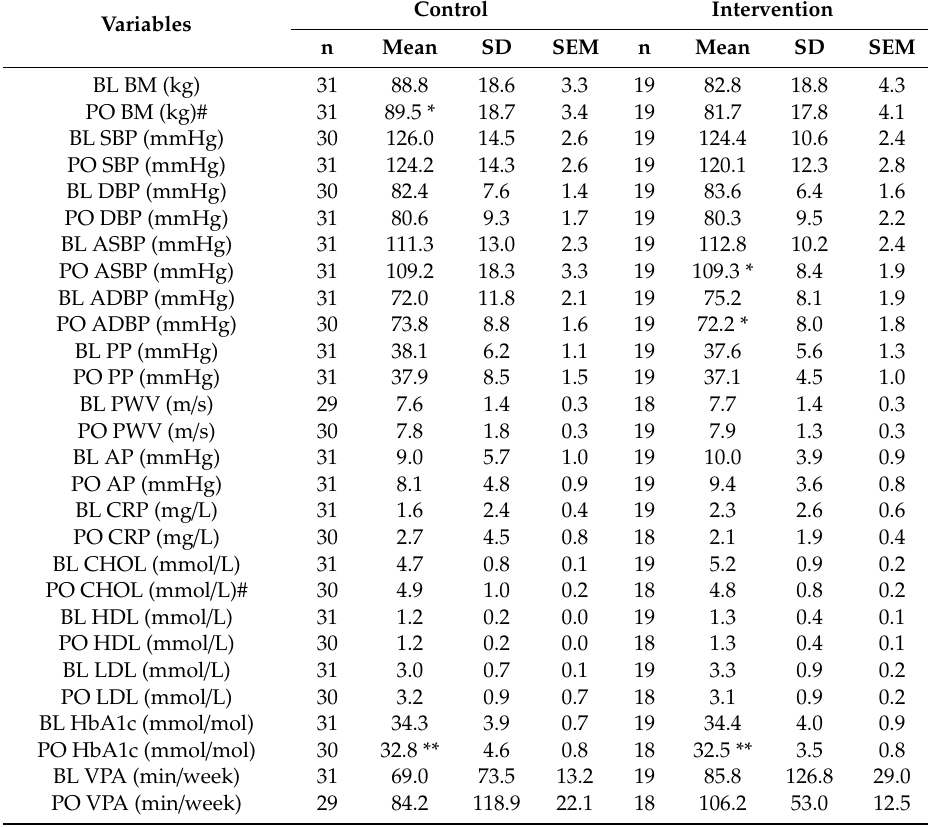
Table 3. Baseline and post-intervention results for control and intervention groups. Variables